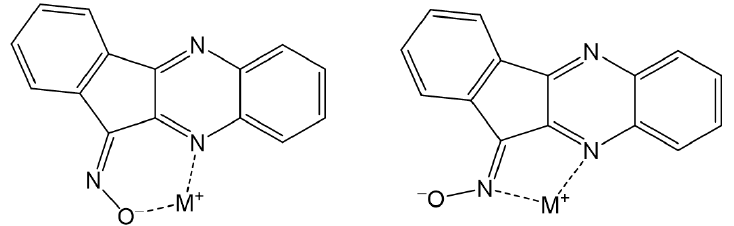
Figure 1. Low-energy geometric structures of the Na + and Li + salts of IQ-1 in non-chelated and che- lated forms of their E and Z isomers.